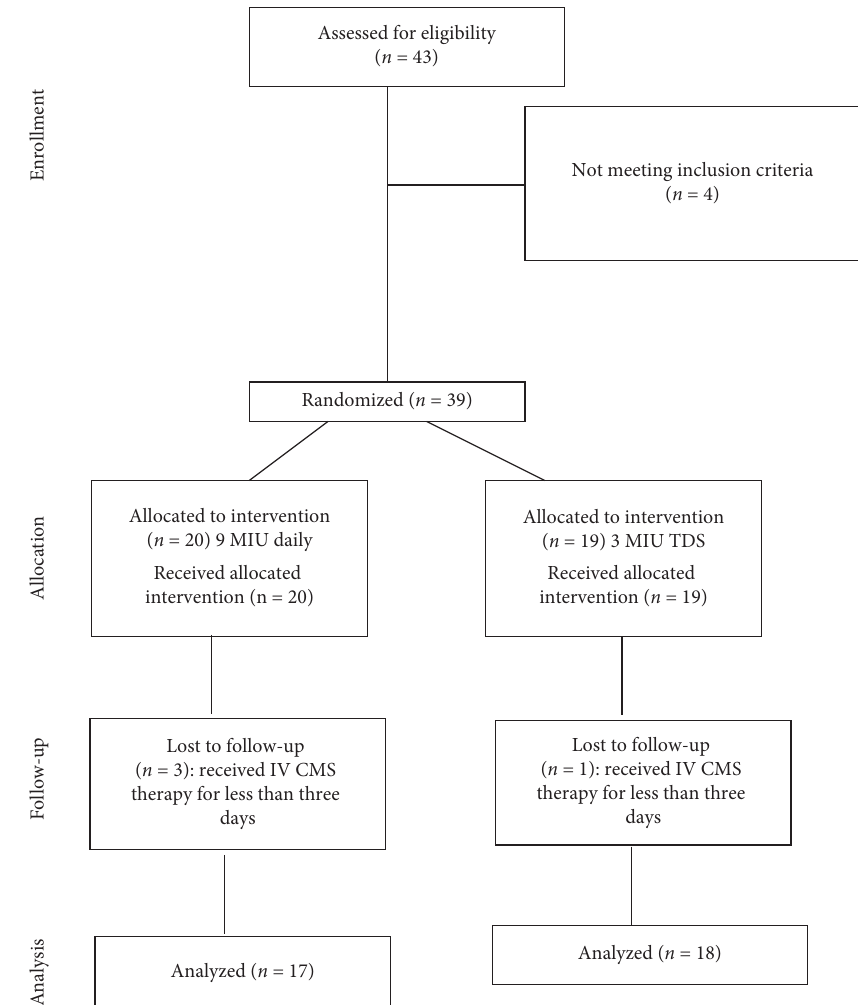
Figure 1: Study diagram. CMS, colistimethate